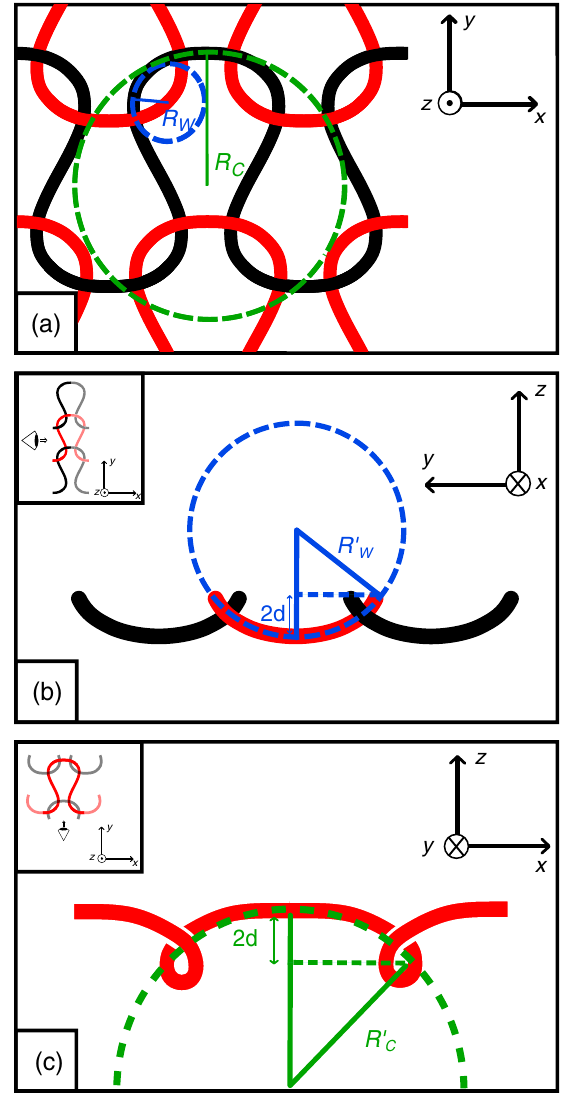
FIG. 4. The main characteristic curvatures of the yarn that can be extracted from the geometry of a stockinette stitch. Panels